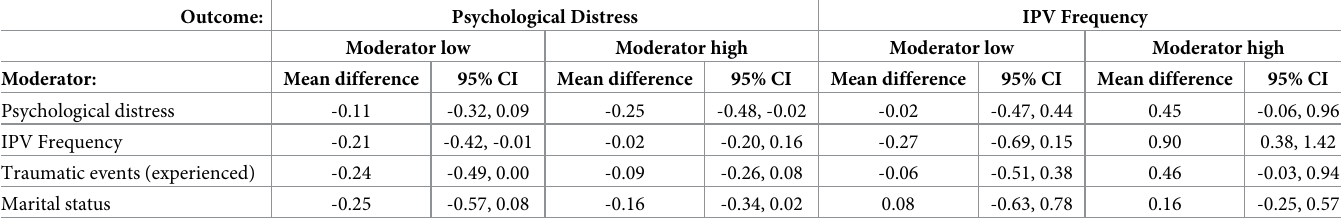
Table 5. Moderators of the difference in psychological distress and IPV frequency by study condition (n =